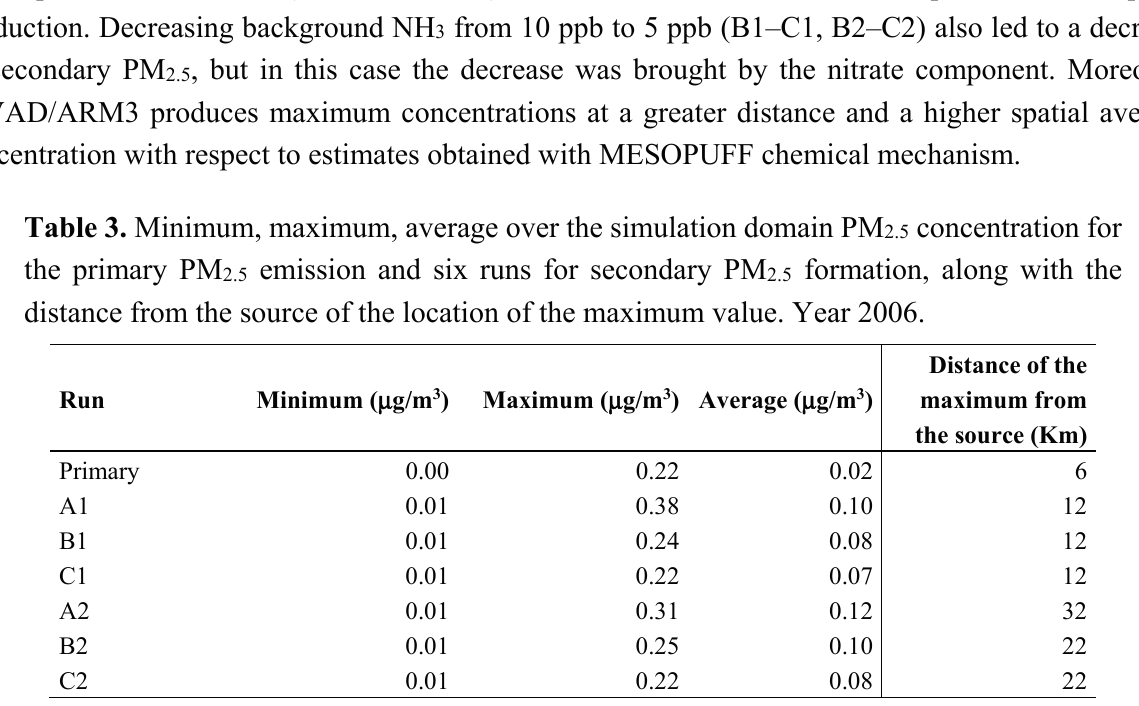
Table 4. Estimated number of non-accidental deaths and 95% confidence interval (95%